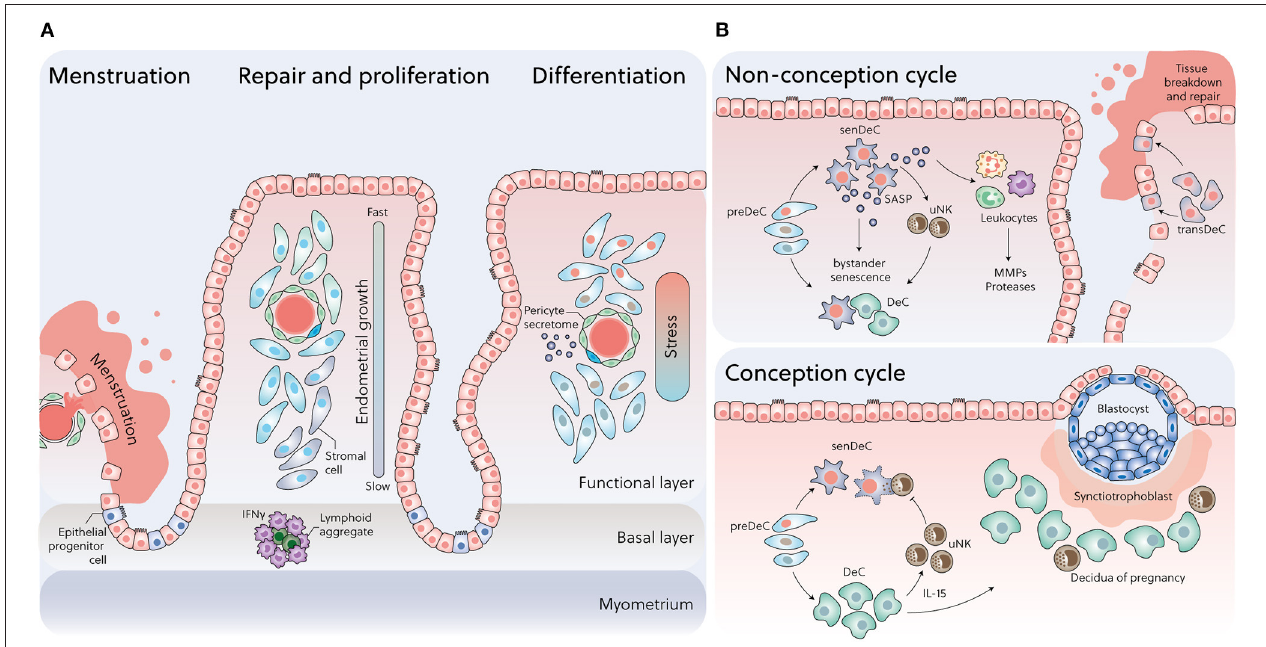
FIGURE 1 | Dynamic changes in cell states across the menstrual cycle. (A) Following menstruation, rapid re-epithelization of the endometrium may involve mesenchymal-epithelial transition (MET), proliferation of epithelial progenitors from unshed areas, or both. Positional oestrogen-dependent proliferation, reflecting an IFN- γ gradient generated by lymphoid aggregates residing in the endometrial-myometrial junction, imposes various levels of replication stress on individual cells during the follicular phase, which in turn drives the divergence in cell states upon decidualization. (B) Upper panel: In a non-conception cycle, falling progesterone levels promote senDeC/transDeC dominance and bystander senescence via prolonged SASP secretion, resulting in leukocyte recruitment and menstrual breakdown. Lower panel: Upon successful embryo implantation, progesterone-dependent DeC cells control rapid clearance of senDeC by recruiting and activating uNK